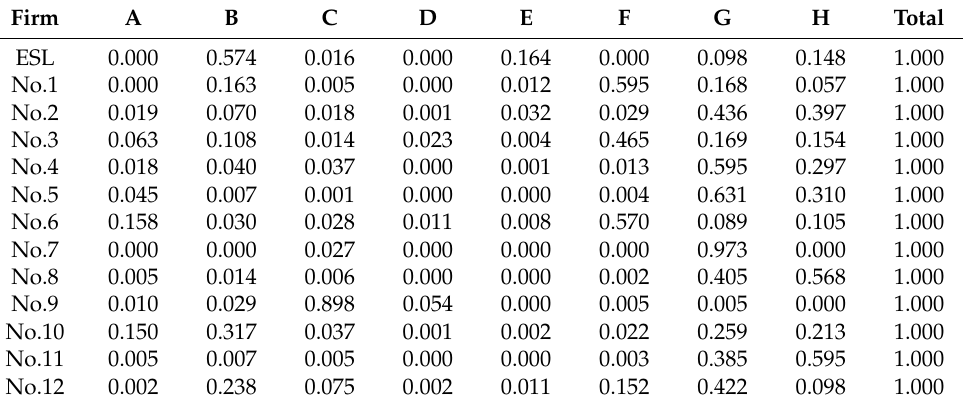
Table 4. Patents distribution of ESL and 12 related firms under the 1st-level